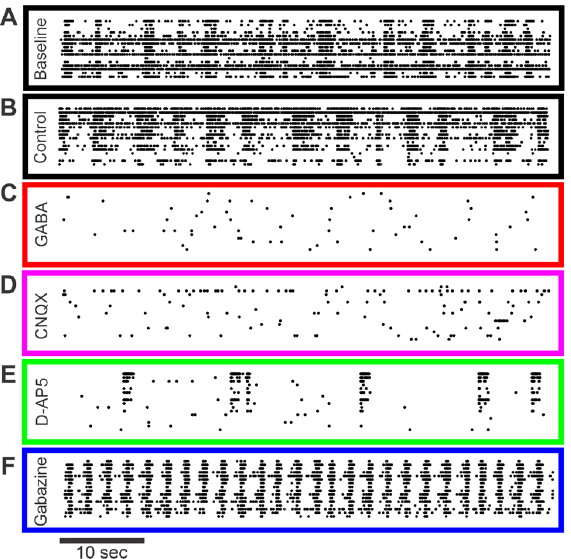
Figure 5. Representative 1-min epochs of rat cortical spike rasters per each experimental condition at 22 days in vitro 21 Rat cortical cultures from microelectrode array well plates were exposed to the following pharmacological agents: baseline ( A ; black), control ( B ; black), GABA ( C ; red), CNQX ( D ; magenta), D-AP5 ( E ; green), and gabazine ( F ; blue). Note that we present the raster in two dimensions here while in our analysis for Fig. 6 we used the two spatial dimensions of the MEA and one temporal